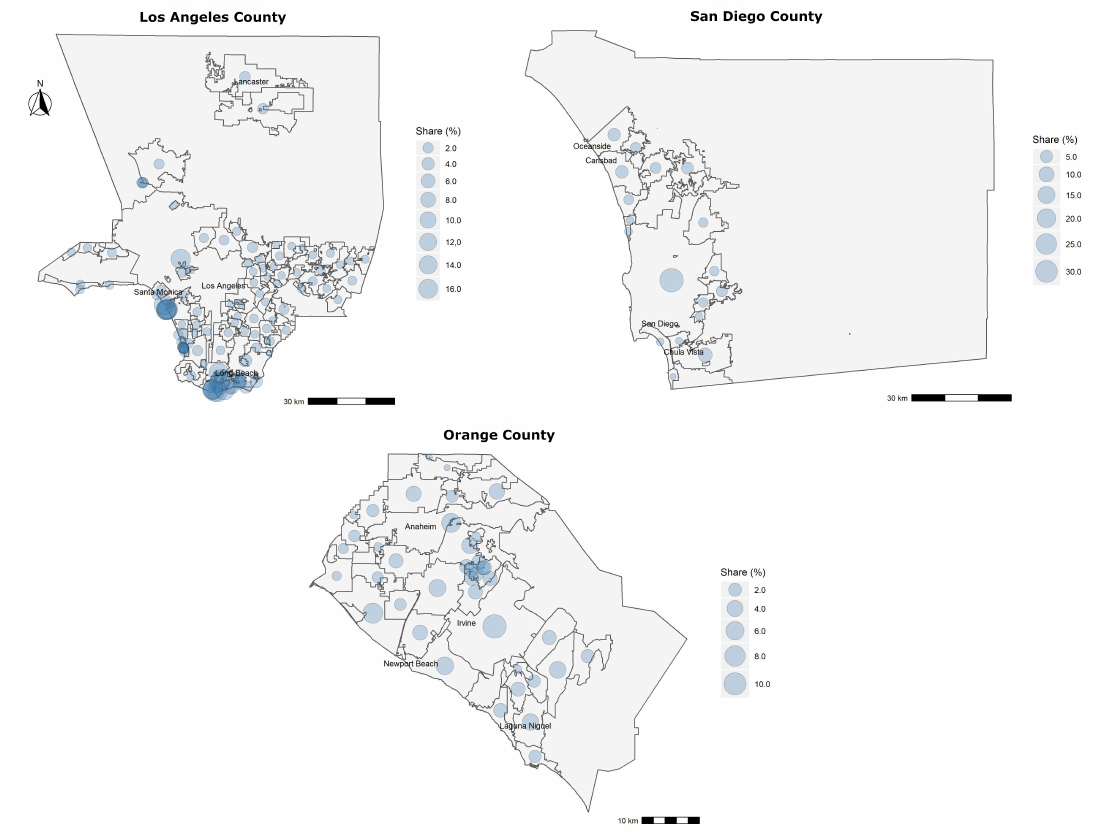
Figure 1. Share of data points for 3 counties in Southern California.